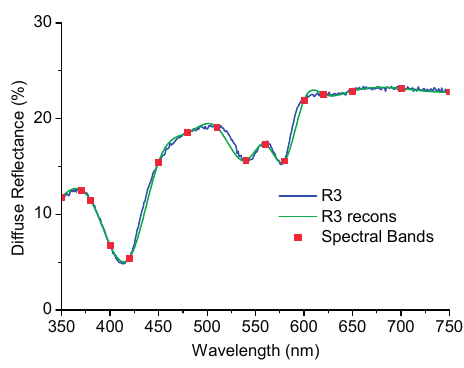
Figure 7. Diffuse Reflectance from phantom 3: Experimental spectra (R3), reconstructed spectra (R3 recons) and the 16 spectral bands used for reconstruction (Spectral bands).